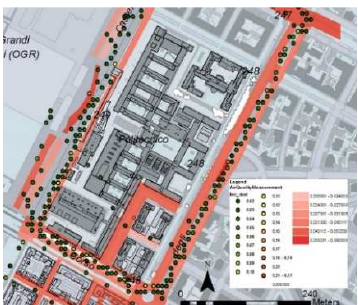
Figure 7: GIS thematic map of the measured PM10 values on the represented